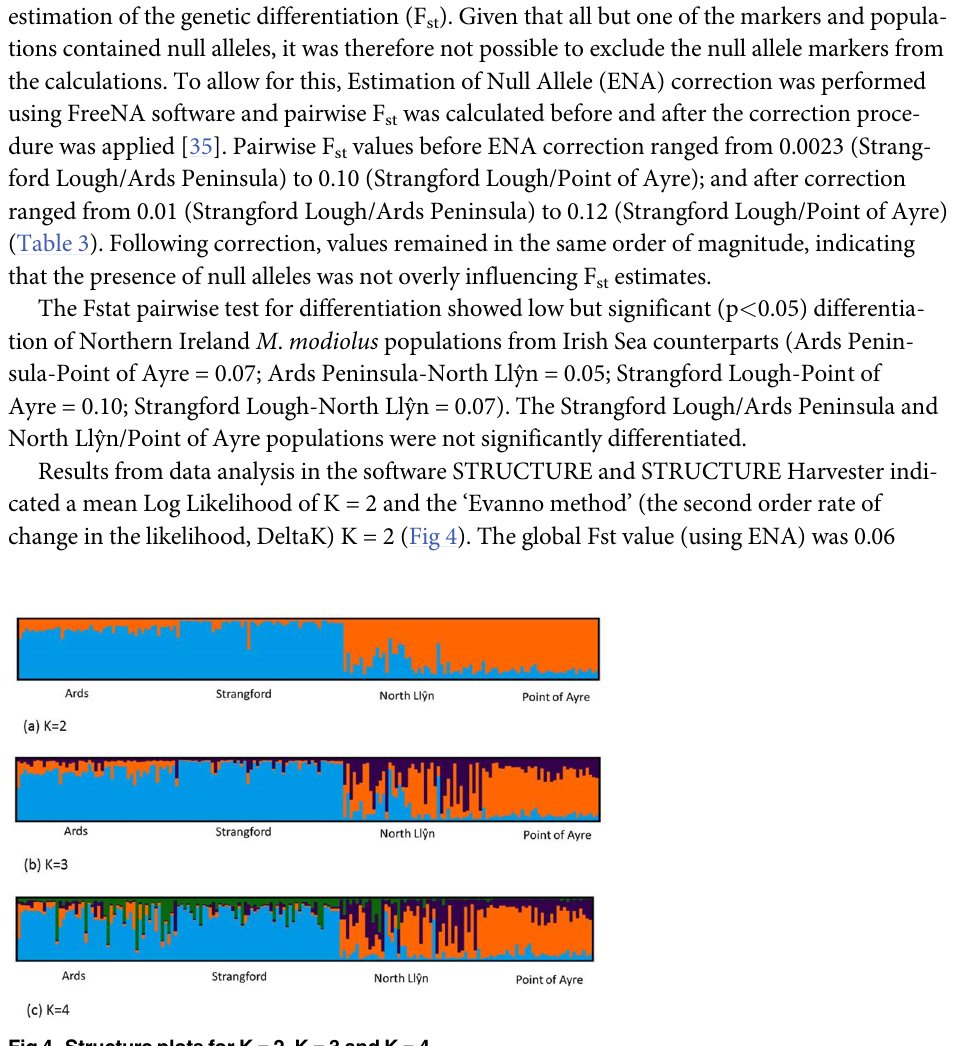
Fig 4. Structure plots for K = 2, K = 3 and K =